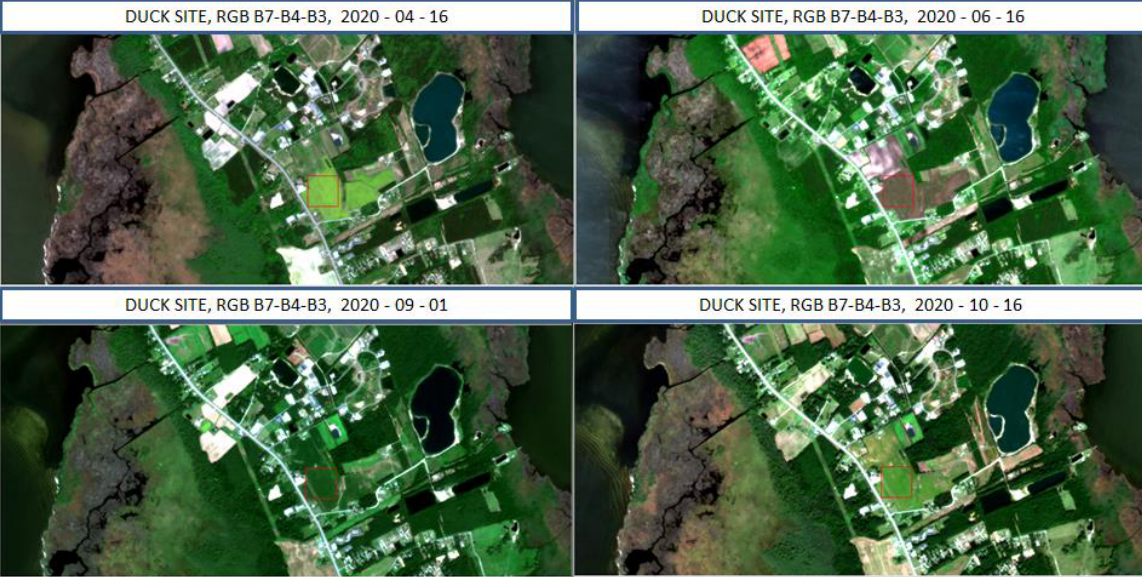
Figure 30. DUCK site, example of the same area on Level-3 products at four different dates.